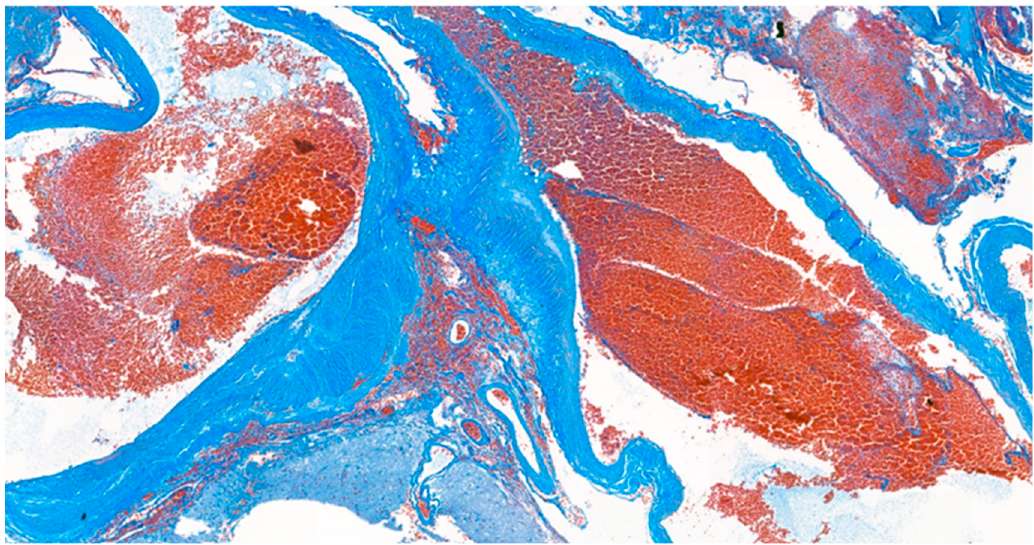
Figure 7. Masson’s trichrome stain. The histological stain revealed abnormally muscularized arteries.